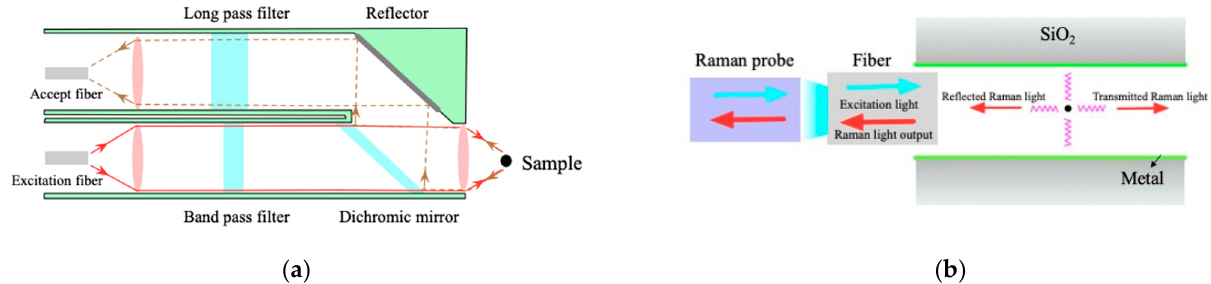
Figure 4. ( a ) Internal structure diagram of Bidatek Raman probe. ( b ) Detection principle diagram of MLHCF. Reproduced with permission [10].